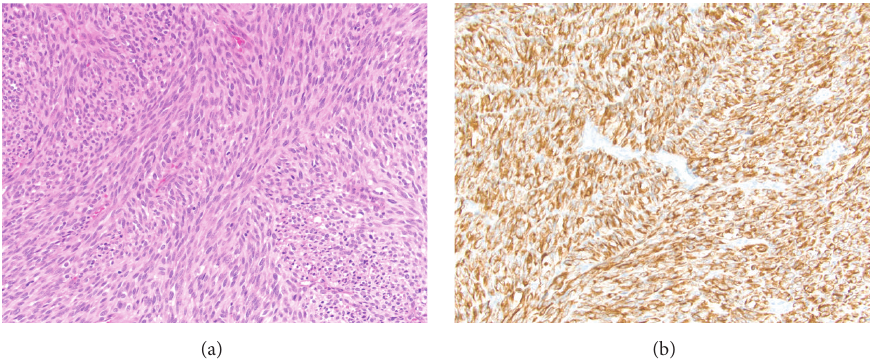
Figure 2: Pathology from the time of definitive surgery revealed a high-grade spindle cell sarcoma growing in fascicles that invaded subfascial tissue ((a), H&E). Immunohistochemical stains demonstrated strong, diffuse positivity for desmin ((b), immunostain). A grade 3 leiomyosarcoma was diagnosed with stage pT2bNxMx.